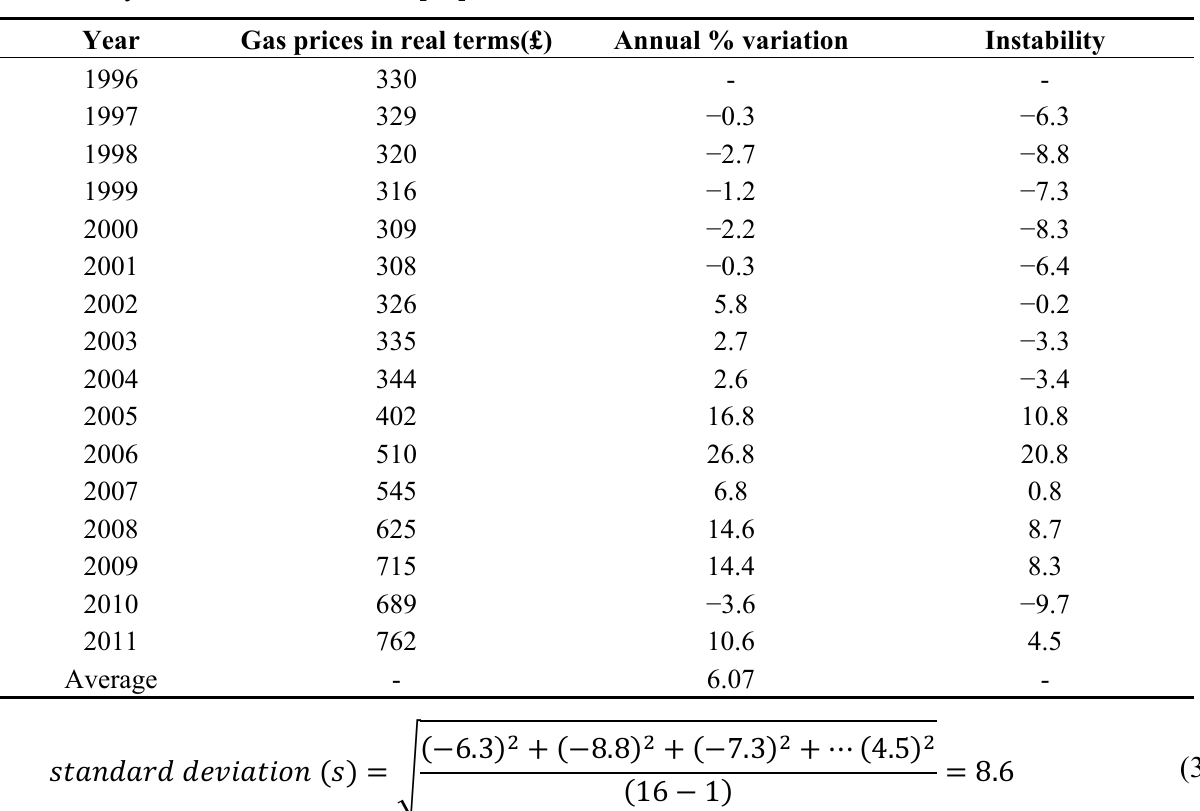
Table 10. Average annual standard credit bills (£) for a typical residential gas consumer for 16 years since 1996 source